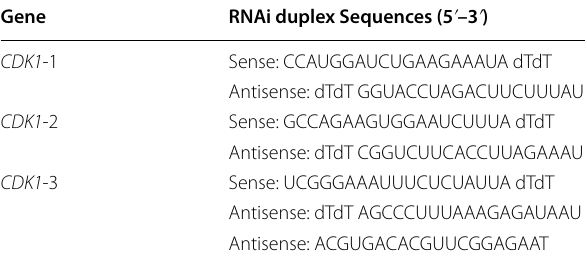
Table 2 RNAi duplex sequences Gene RNAi duplex Sequences (5 ʹ –3 ʹ